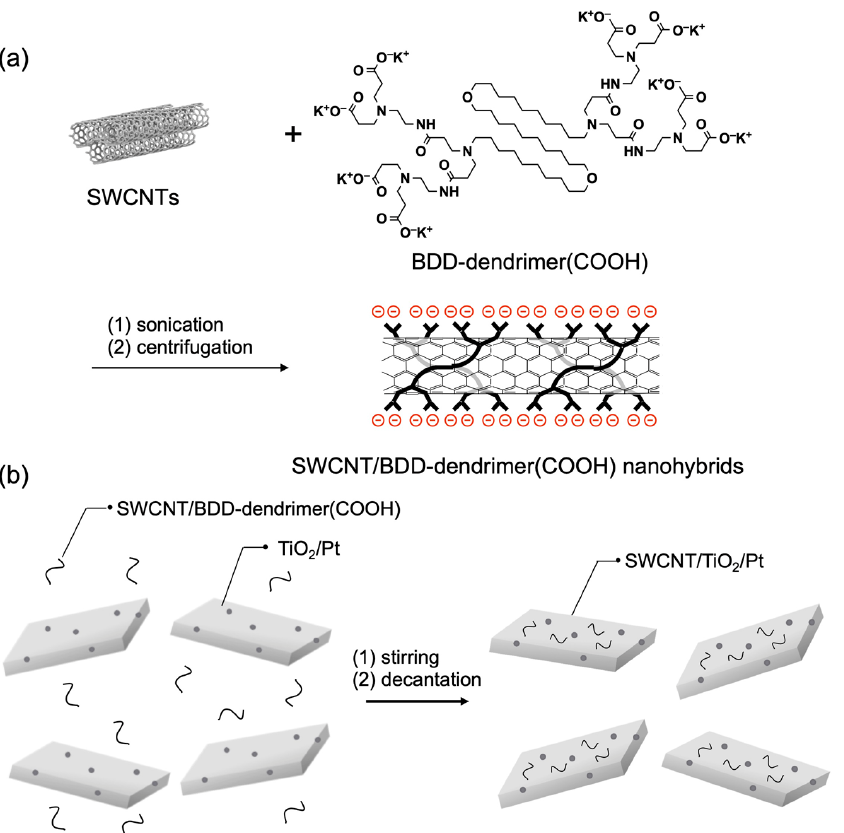
Figure 1. Fabrication of ( a ) the SWCNT/BDD-dendrimer(COOH) nanohybrids, and ( b ) SWCNT/TiO 2 /Pt nanohybrids.